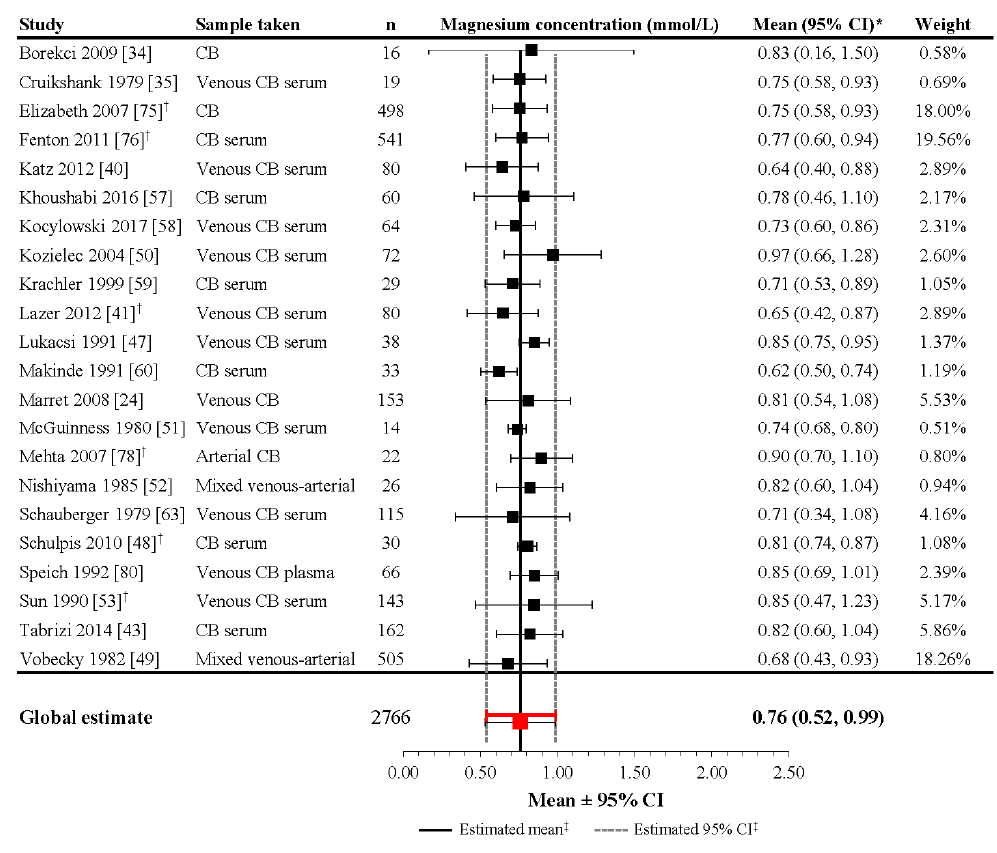
Figure 2. Magnesium concentrations in umbilical cord blood of healthy newborns without magnesium supplementation during pregnancy. * If 95% CIs were not reported in the study, then the 95% CIs were calculated as follows: mean ± (1.96 × SD). † Patient groups within these studies were pooled, as the literature search did not confirm an association between magnesium levels and gestational age, birth weight, or mode of delivery. ‡ Reference line and 95% CI derived using only studies reporting both mean and SD data. Overall statistic for heterogeneity: I 2 = 98.3% ( p < 0.001). CB: [umbilical] cord blood; CI: confidence interval; n: number of infants; SD: standard deviation.